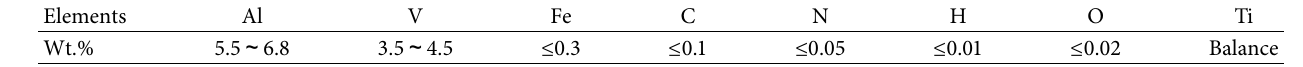
Table 1: The chemical composition of TC4 titanium alloy (wt.%).